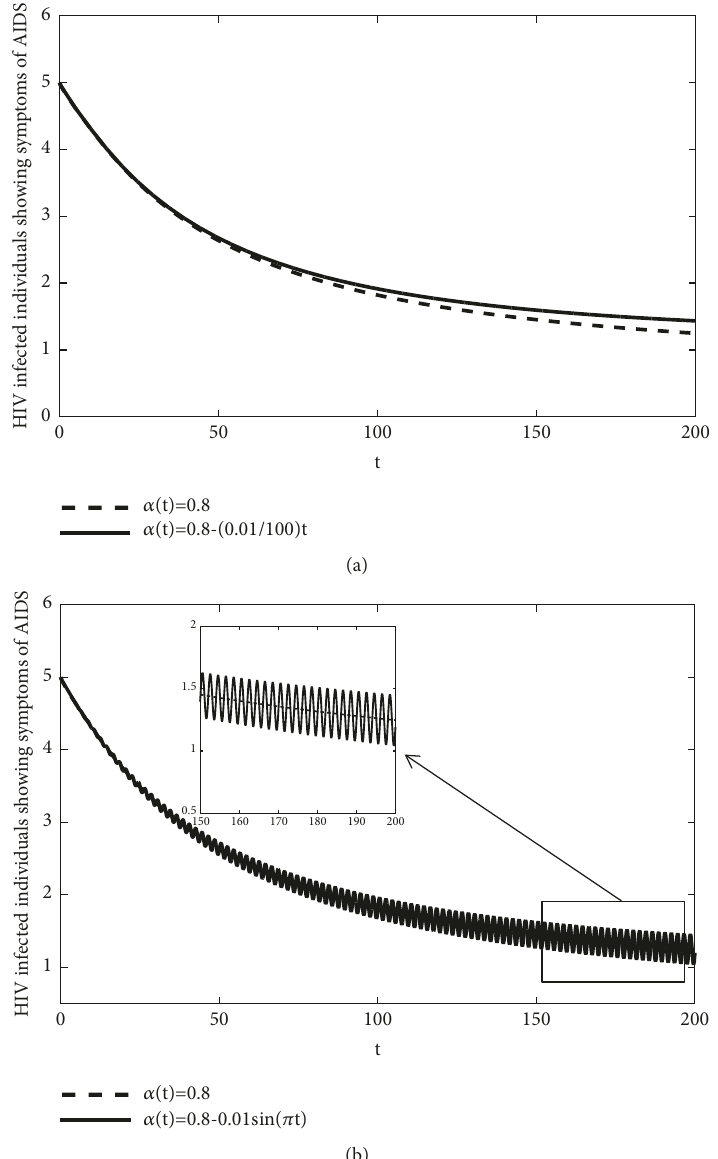
Figure 3: HIV infected individuals showing symptoms of AIDS with ] 2 = 100 . Parameters values are in Table 1 with 𝛽 ℎ = 0.01 . (a) 𝛼(𝑡) = 0.8 comparing with 𝛼(𝑡) = 0.8 − (0.01/100)𝑡 ; (b) 𝛼(𝑡) = 0.8 comparing with 𝛼(𝑡) = 0.8 − 0.01 sin (𝜋𝑡)